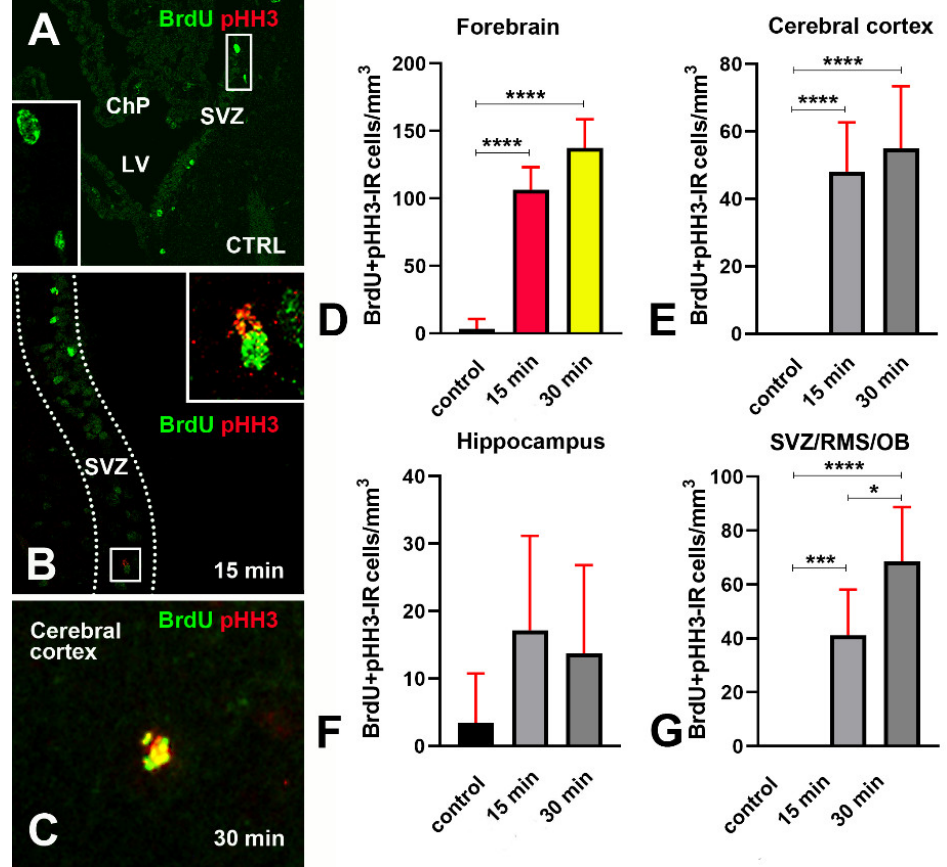
Figure 15. BrdU+pHH3 double-labeling experiments in the forebrain of control and irradiated mice. ( A ) exemplificative image of the pattern of immunostaining in the SVZ of a control nonirradiated mouse. Note that all immunoreactive cells are singularly labeled for BrdU (green) and the lack of double-labeled cells. The two BrdU+ cells in the rectangle are shown at higher magnification in the insert. ( B ) exemplificative image of the pattern of immunostaining in the SVZ of a mouse that survived 15 min after irradiation. Note that most immunoreactive cells are singularly labeled for BrdU (green). The two cells in the square appear at higher magnification in the insert. Note the presence of foci of colocalization (yellow) of the two labels, which are particularly evident in the top cell that is mainly reactive for pHH3 (red). ( C ) exemplificative image of the pattern of immunostaining in the cerebral cortex of a mouse that survived 30 min after irradiation. Note that the cell is double- labeled and displays clear foci of immunoreactivity for BrdU (green), pHH3 (red), or both (yellow). ( D – G ) Quantitative analysis of the volumetric density of double-labeled cells in the whole forebrain, cerebral cortex, hippocampus, and SVZ/RMS/OB. Abbreviations: ChP = choroid plexus; LV = lateral ventricle; SVZ = subventricular zone of the lateral ventricle. Original magnifications: ( A , B ) 20 × ; ( C ) and inserts, 40 × . Data are expressed as mean ± 95% CI. * 0.05 > p ≥ 0.01, *** 0.001 > p ≥ 0.0001, **** p < 0.0001. Bars are 95% CI. See Appendix K for numerical data of statistics. Venn diagrams in Figure 16 show the trend of BrdU+pHH3 co-labeling in control mice and after X-rays administration. If we consider the forebrain, it is remarkable that, in control mice, BrdU+pHH3 double-labeled cells represented 5.55% of the total number of BrdU-only immunoreactive cells, but such a percentage increased substantially in those animals that survived 15 or 30 min—to 24.41% and 25.64%, respectively. Altogether, our results indicated that an attempt to synthesize new DNA and a mitotic/pseudo-mitotic response in the damaged cells accompanied the DDR triggered by